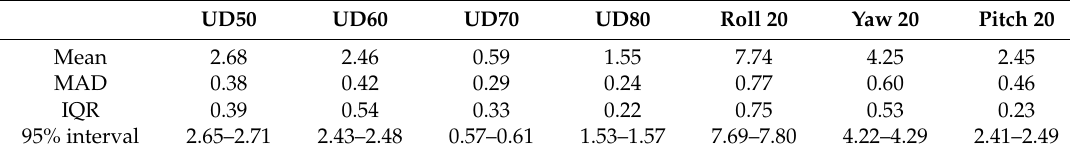
Table 7. Gaze error statistics from tablet experiments (table values in